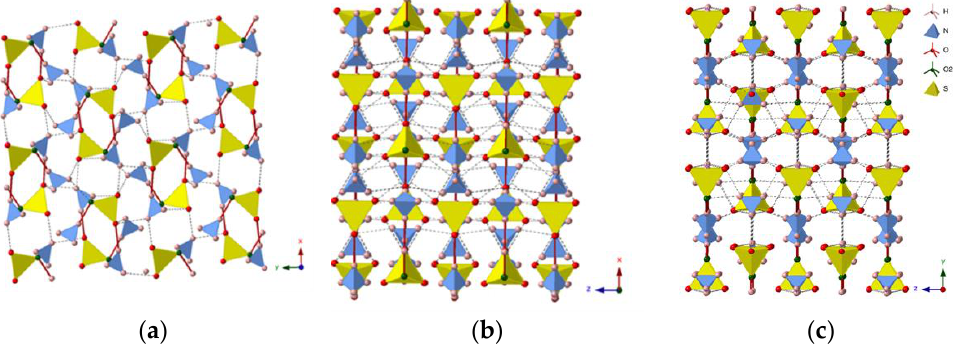
Figure 1. ( a ) Crystal structure of mascagnite projected along ( a ) [001], ( b ) [010], ( c ) [100]. The red segments indicate the H-O distances below 2 Å , whereas the dotted segments indicate the H-O distances above 2 Å .